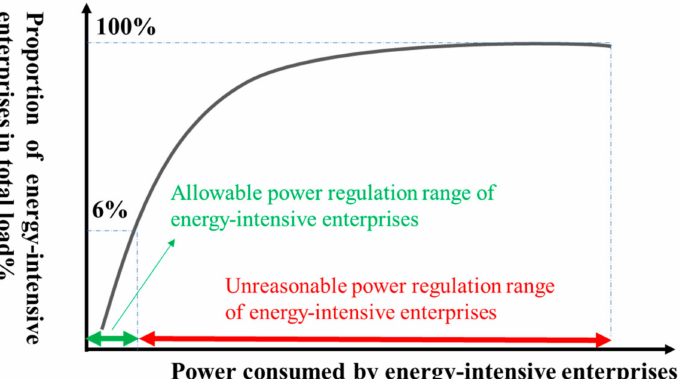
Figure 5. The power regulation range of the electrolytic aluminum load.